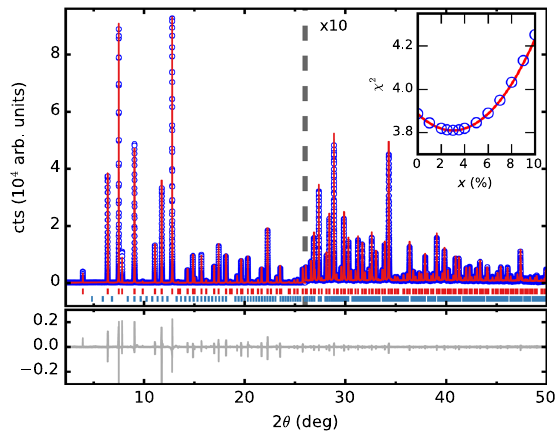
FIG. 9. Rietveld analysis of high-resolution synchrotron x-ray data collected on 11-BM at 100 K. Blue circles are measured data, red line is the calculated diffraction pattern, and red vertical bars indicate the positions of nuclear reflections in the Fd space group. There is also a contribution from a 0.15% Sc 2 O 3 contamination phase. The difference between calculated and measured data is shown in the lower panel. Inset: Goodness- of-fit parameter ( χ 2 ) versus the Fe-Sc antisite inversion. The Sc 2 O 3 contamination phase is not included in refinements used to determine the site